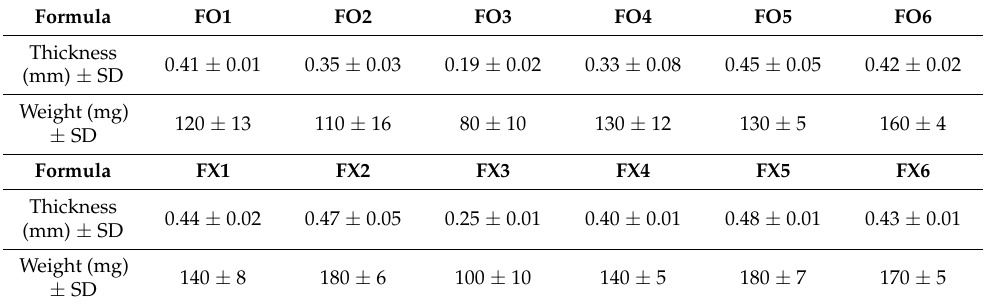
Table 3. Thickness and weight of the orodispersible